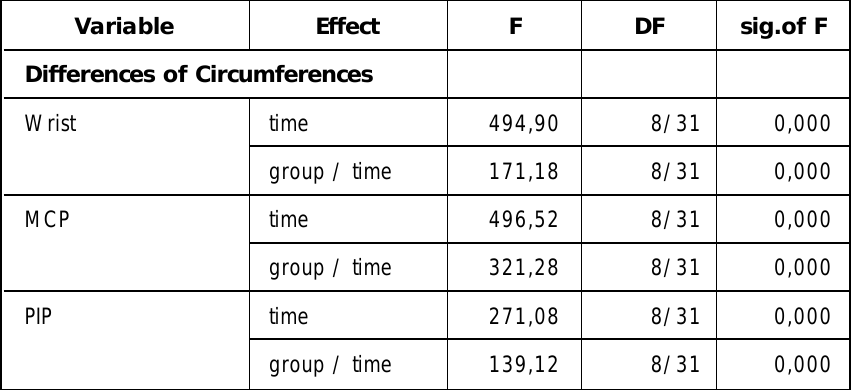
Table 3: Summary of Multivariate Tests (Wilks Roys) for Differences of